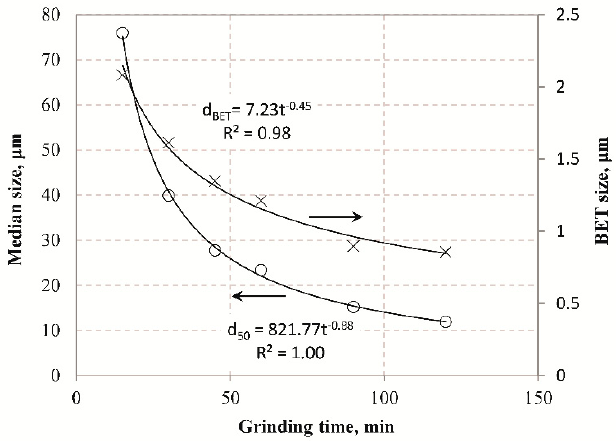
Figure 5. Evolution of median size (d 50 ) and Brunauer–Emmett–Teller (BET) size with grinding time.